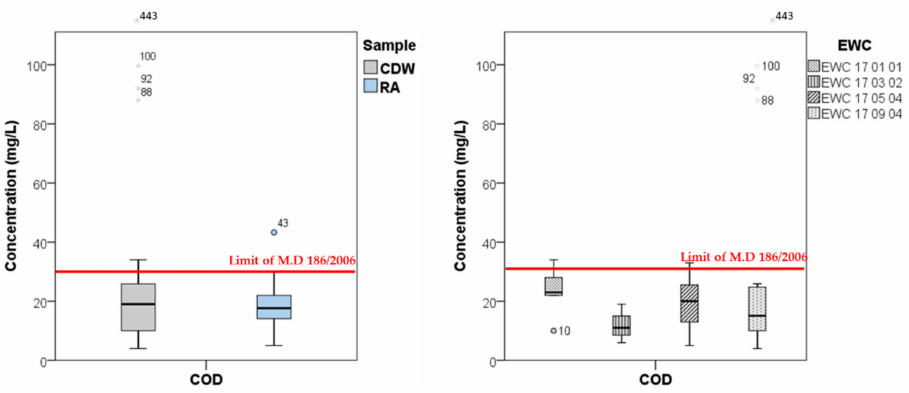
Figure 8. COD release in CDWs and RAs ( left ) and EWC code responsible for the highest re- lease ( right